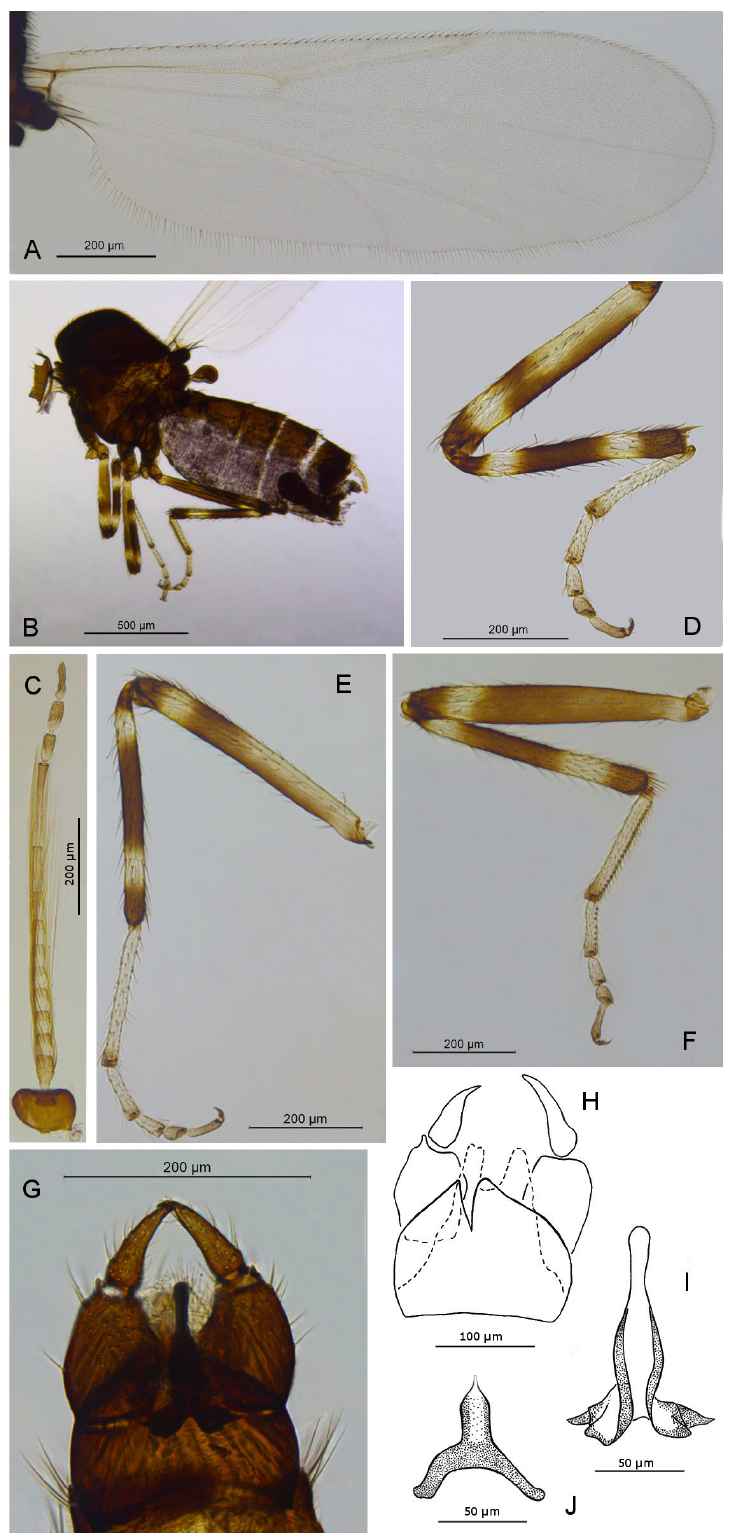
Fig. 1. Bezzia libanensis Alwin & Szadziewski sp. nov. , ♂. A . Wing. B . Thorax. C . Antennal scape and flagellum. D . Fore leg. E . Mid leg. F . Hind leg. G . Male genitalia. H . Male genitalia, ventral view. I . Parameres. J .